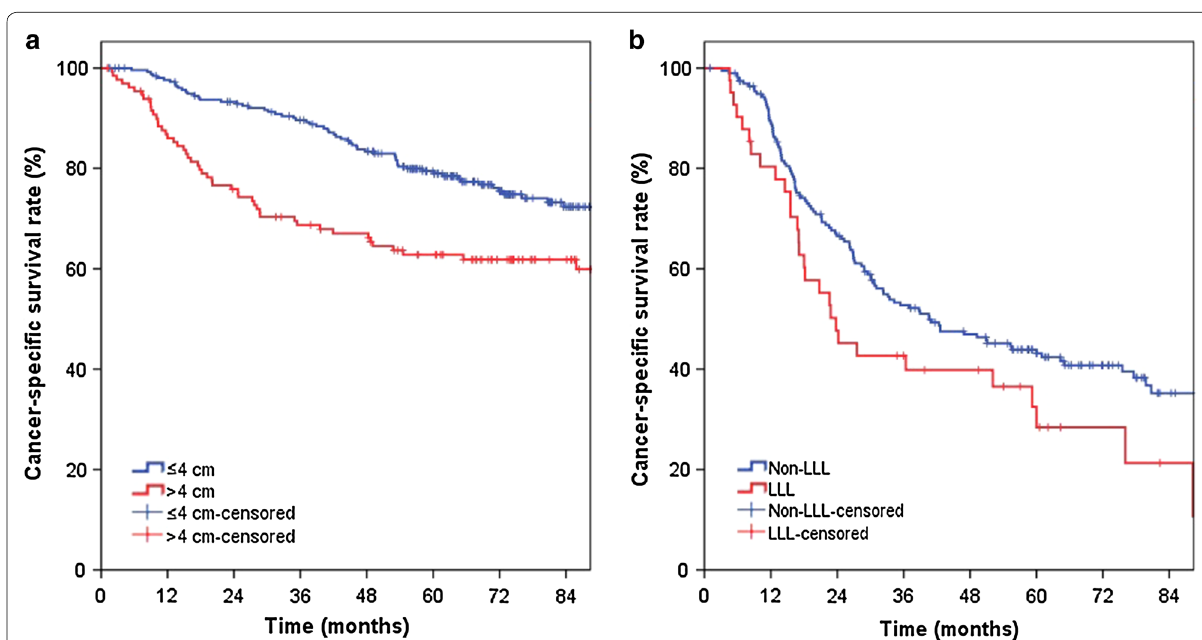
Fig. 1 Kaplan–Meier survival analysis in patients with resectable non–small cell lung cancer (NSCLC). a The relationship between tumor size ( vs. >4 cm) and cancer‑specific survival in patients with resectable NSCLC without nodal involvement ( P < 0.001); b the relationship between tumor location [left lower lobe (LLL) vs. non‑LLL] and cancer‑specific survival in patients with resectable NSCLC and nodal involvement ( P